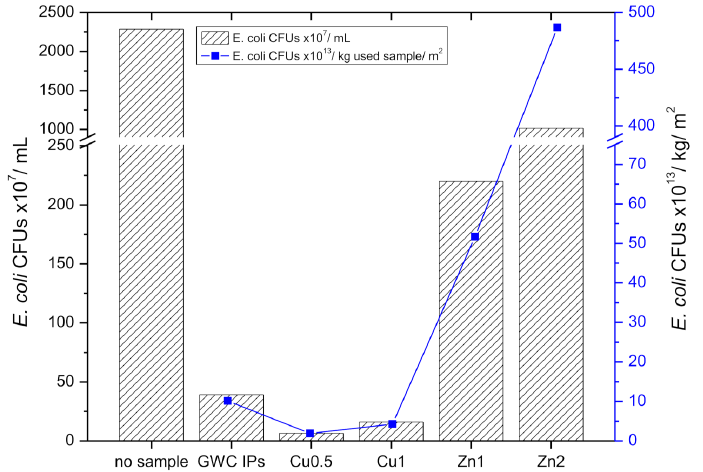
Figure 10. E. coli bacteria growth in the presence of GWC IPs embedded with CuO and ZnO NPs ( E. coli CFUs/mL); ( E. coli CFUs/kg used material/m 2 ) as a function of NPs loading in GWC IPs (in